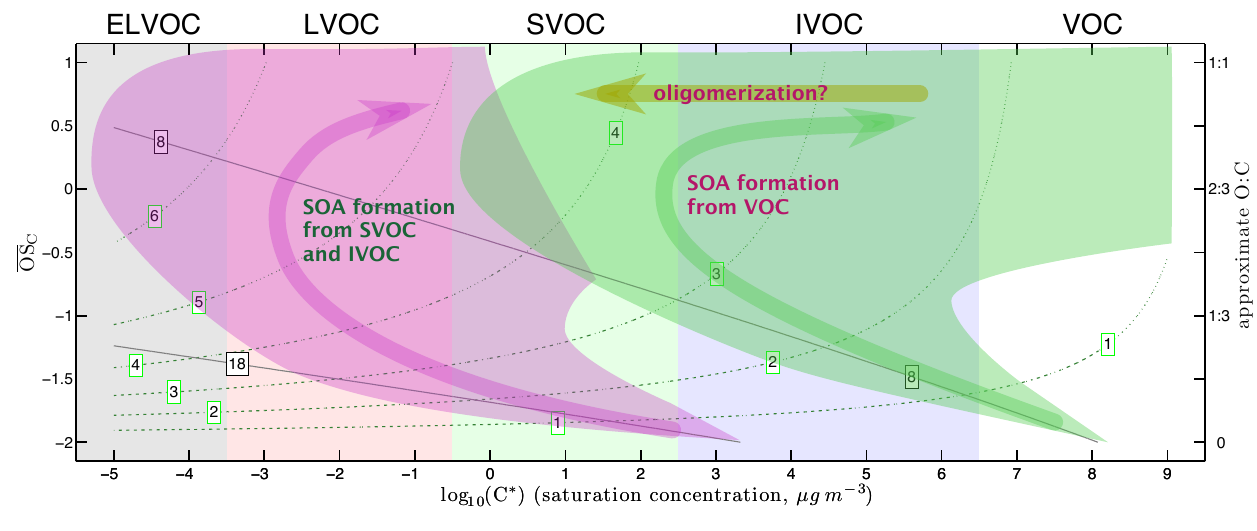
Fig. 7. Two reaction trajectories in 2-D space. Contours are carbon number (gray) and oxygen number (dashed green) as in Fig. 5. SOA formed from VOCs (shown at C 8 ) moves rapidly upward in OS C but reaches a minimum in C ∗ only barely sufficient to form any SOA in the atmosphere. SOA formed from SVOCs and IVOCs (shown at C 18 ) moves more slowly upward in OS C but reaches very low C ∗ values. Both trajectories ultimately result in complete fragmentation (in the limit where the chemistry is allowed to continue to completion), and both consist of a cloud of individual reaction pathways initially centered on the mean carbon contour for the parent carbon number. A potential oligomerization trajectory is shown as